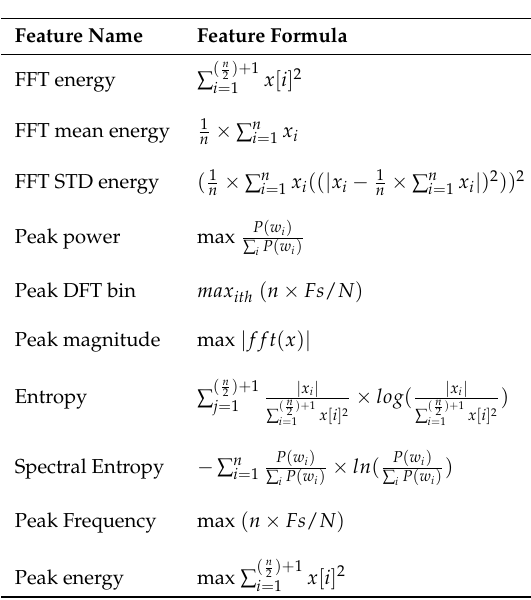
Table 5. New frequency-domain attributes.